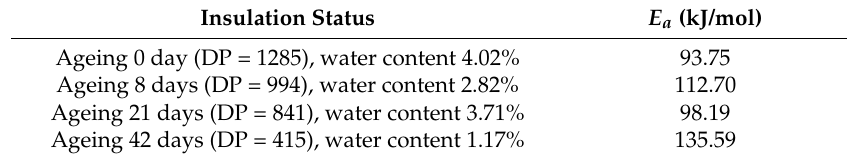
Figure 10. Relations between ln σ paper and 1/T. ( a ) Ageing 0 day (DP = 1285), moisture content 4.02%; ( b ) Ageing 8 days (DP = 994), moisture content 2.82%; ( c ) Ageing 21 days (DP = 841), moisture content 3.71%; and, ( d ) Ageing 42 days (DP = 415), moisture content 1.17%. Table 1. A ctivation energy values of experimental pressboard specimens with various insulation statuses.